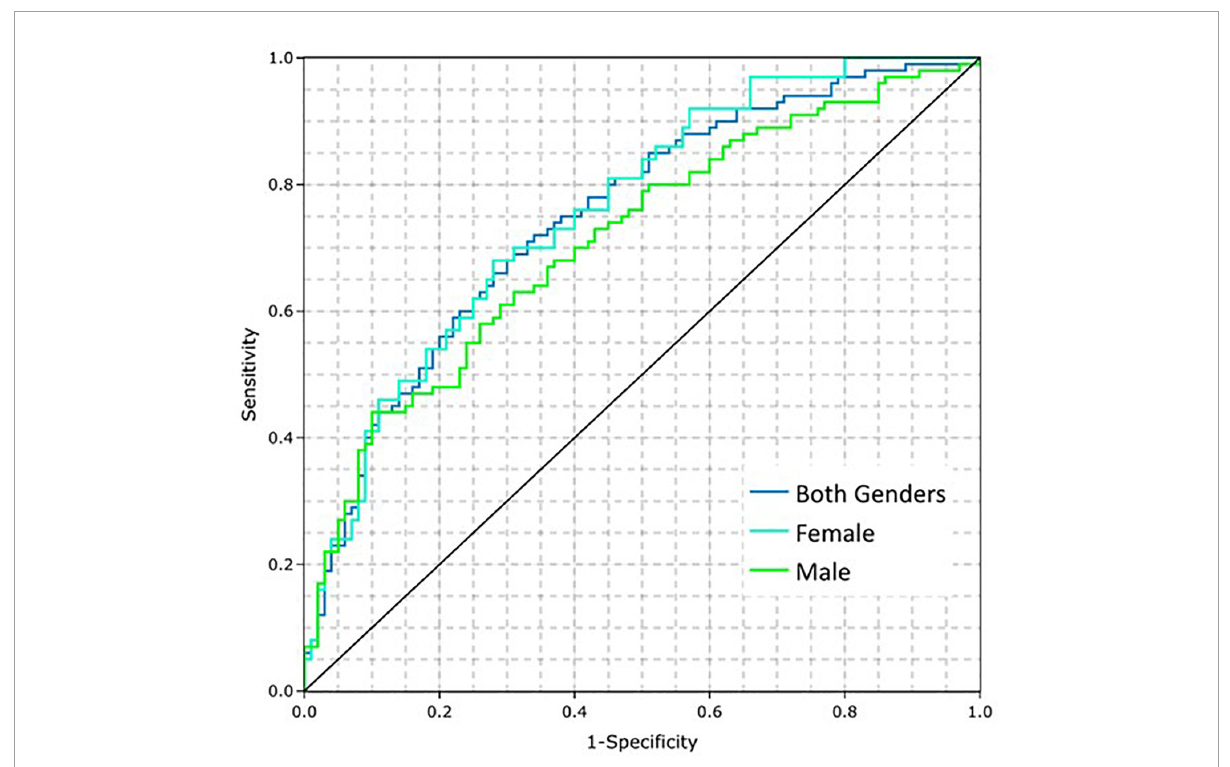
FIGURE3 Coronary artery disease (CAD) model performance on the training dataset by